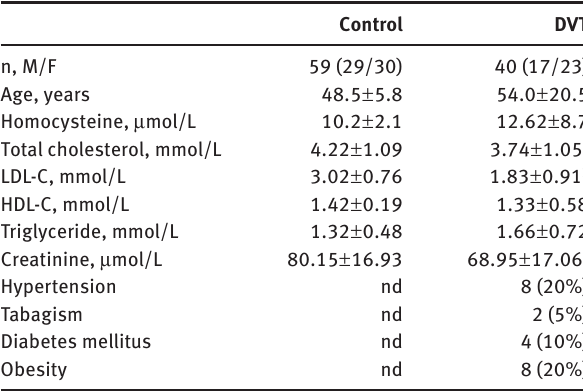
Table 1 Characteristics of the cases and controls. Table 2 Correlation between serum total homocysteine (t-Hcy) level and risk factors between deep venous thrombosis patients.